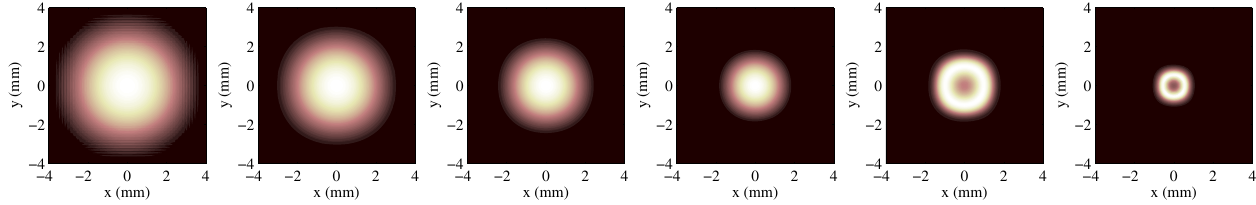
FIG. 5. Coherent photon beam spatial profile from six single radiator segments, where a stepped taper is applied to the last two radiator undulators for radiation power enhancement.